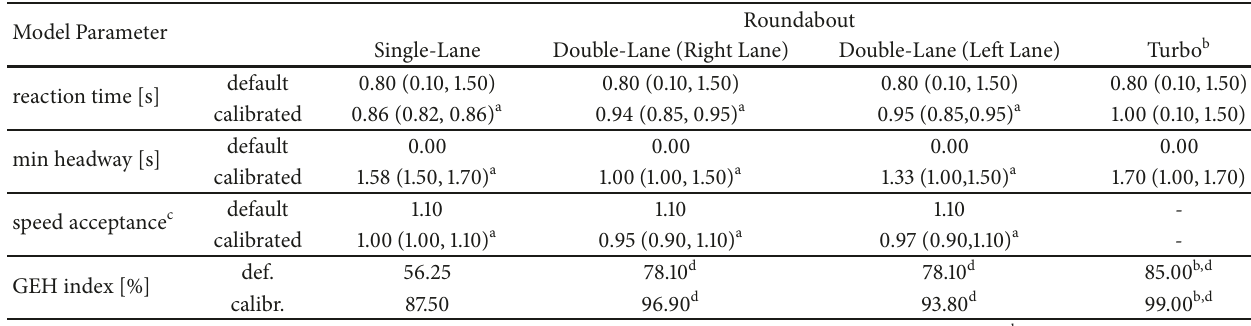
Table 4: Default and calibrated values of the model parameters in AIMSUN. Model